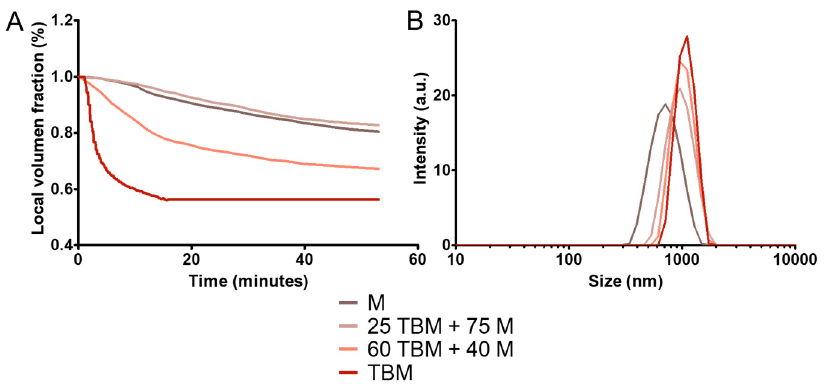
Figure 5. Colloidal stability of M, 25 TBM + 75 M and 60 TBM + 40 M. Height normalized to its initial volume value as a function of time ( A ). Hydrodynamic size in intensity distribution for the di ff erent formulations ( B ).